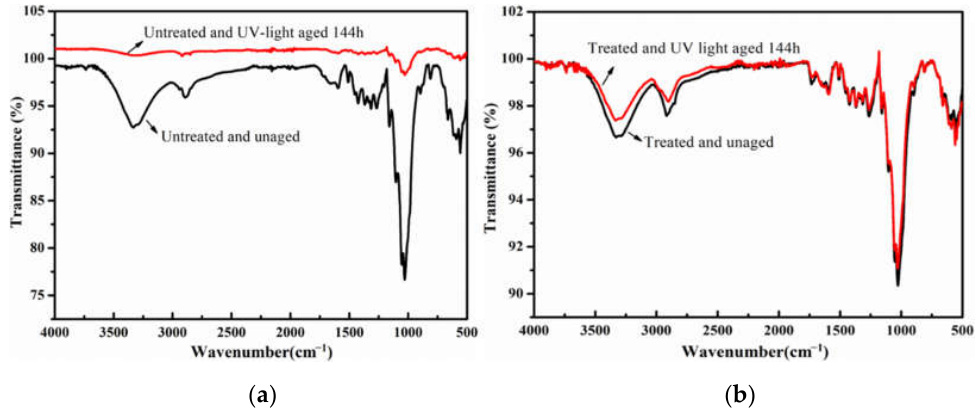
Figure 8. The IR spectra of paper-based documents before and after UV aging: untreated ( a ) and treated ( b ).